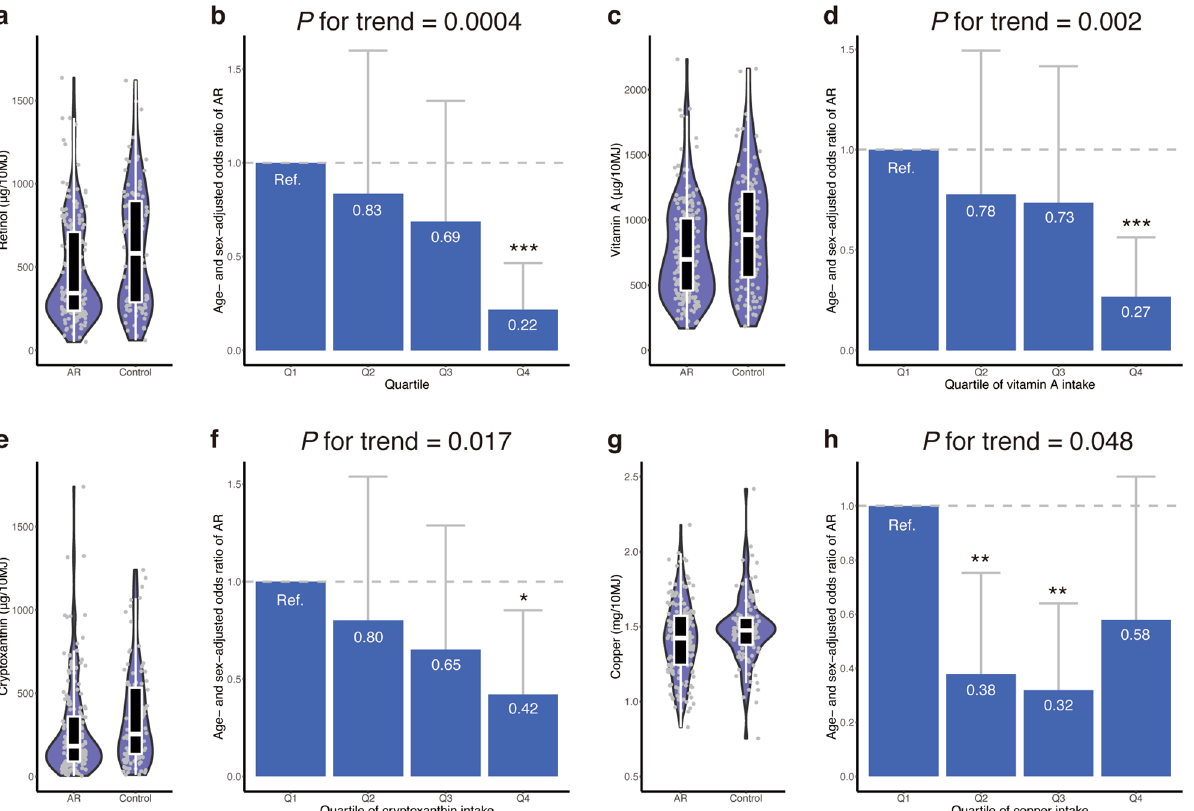
Figure 1. Nutrients associated with allergic rhinitis. The distribution of energy-adjusted nutritional intake is shown for ( a ) retinol, ( c ) vitamin A, ( e ) cryptoxanthin, and ( g ) copper. Outlier data points are excluded from these plots. The age- and sex-adjusted odds ratio of allergic rhinitis is presented for ( b ) retinol, ( d ) vitamin A, ( f ) cryptoxanthin, and ( h ) copper. Error bars indicate 95% confidence interval. ‘*’ indicates P < 0.05; ‘**’, P < 0.01; and ‘***’, P < 0.001. AR, allergic rhinitis; Q, quartile; Ref., reference